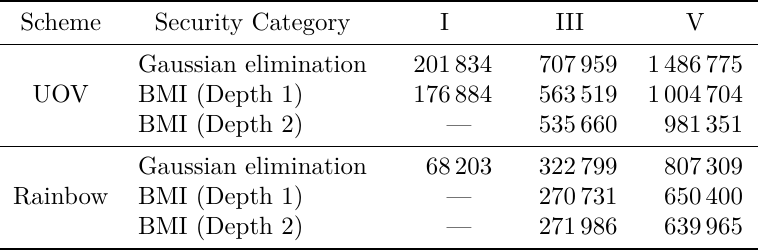
Table 5: UOV/Rainbow implementation results with the BMI method at three security categories in CPU